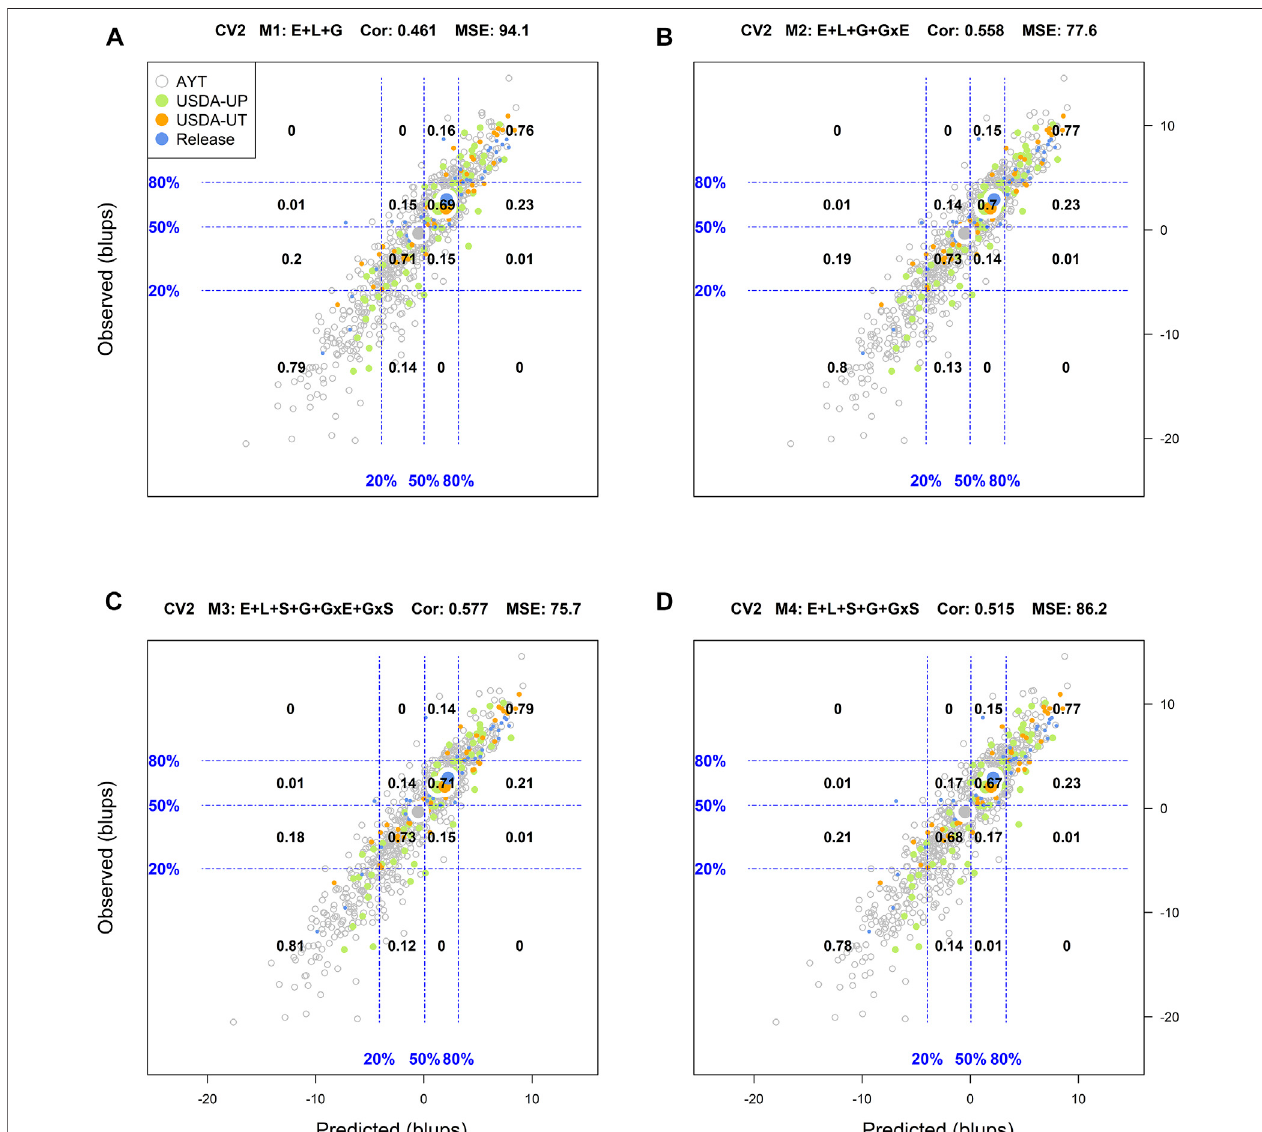
FIGURE 1 | Genotypic means (BLUP-centered on zero within environments) of observed versus predicted cross-validation predictions of four models (M1 – M4) underthecross-validation schemeCV2,whichmimics theincomplete fi eldtrialprediction scenario(predictingtestedgenotypesinobservedenvironments). Modelsand terms are described in detail in the Materials and Methods section ( Eqs 1 – 4 ). Horizontal and vertical dashed lines indicate the 20, 50, and 80% empirical percentiles correspondingtothegenotypicmeansofobservedandpredictedvalues;thenumbersinsidethegridprovidetheconditionalproportionsobservedonthe y -axisfor thedifferentpercentiles onthe x -axis(e.g.,outofthetop20%ofthepredictedvalueswithM3(panelC),79%[top right]ofthesecorrespondtogenotypesthatshoweda performance among the 20% across fi elds).